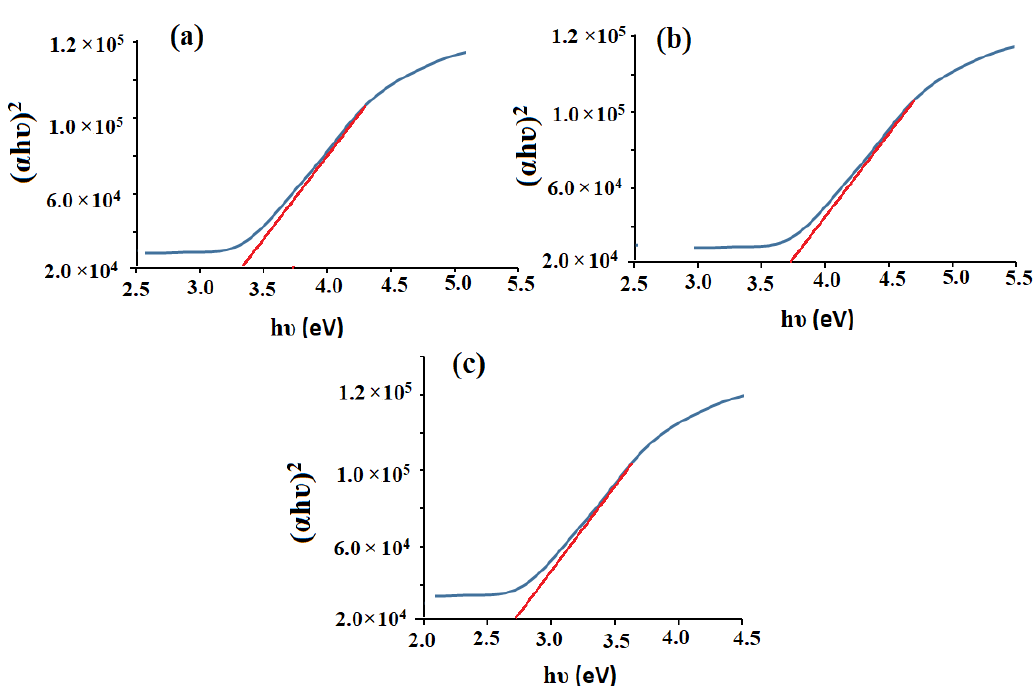
Figure 4. Bandgaps of the pre-synthesized ( a ) CeO 2 NPs, ( b ) Al 2 O 3 NPs, and ( c ) CeO 2 /Al 2 O 3 NPs. The pre-synthesized CeO 2 NPs, Al 2 O 3 NPs, and CeO 2 /Al 2 O 3 nanocomposite FT-IR spectra were measured in the 400–4000 cm − 1 region. CeO 2 NPs’ FT-IR spectrum (Figure 5a) revealed absorption bands at 3400 cm − 1 (O-H stretching vibration), 1626 cm − 1 (O-H bend- ing vibration of absorbed water), and 488 cm − 1 (Ce-O-Ce) stretching vibration and 555 cm − 1 (formation of Ce-O stretching bond). The obtaining results are consistent with prior find- ings [53]. The FT-IR spectrum of the Al 2 O 3 NPs is described in Figure 5b.